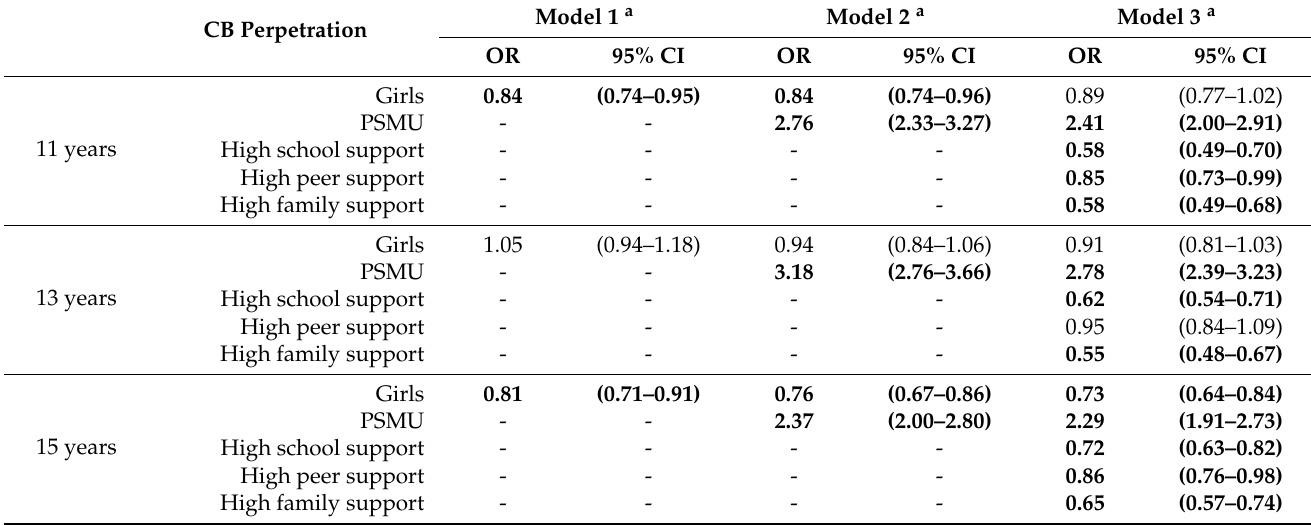
Table 3. Odds ratio (OR) and 95% confidence interval (CI) for cyberbullying perpetration, by age, gender, PSMU, and social support (school peers and family); Italian HBSC